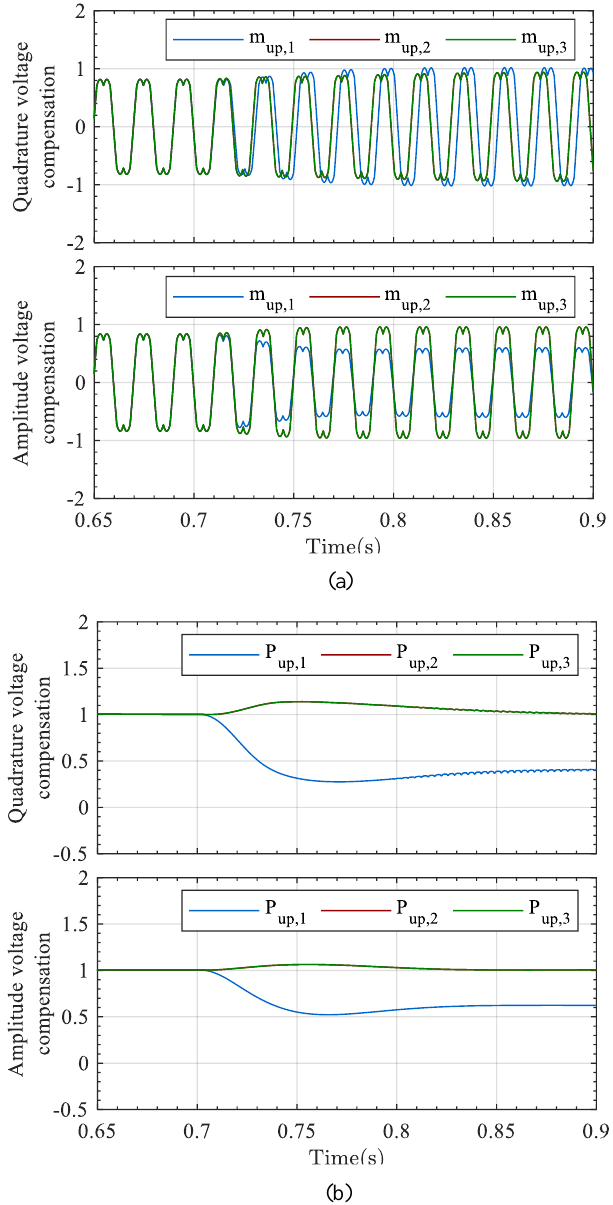
Figure 17. Comparative analysis between quadrature and amplitude voltage compensation. ( a ) Mod- ulation index, ( b ) active power per